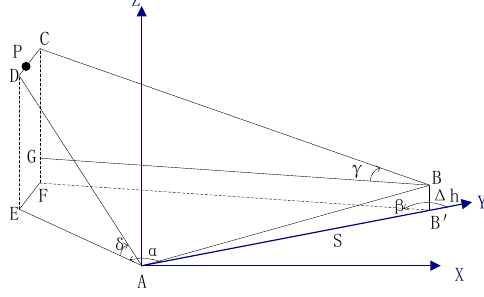
Figure A1. The schematic diagram of a 3-D locating algorithm for two-station. Reference